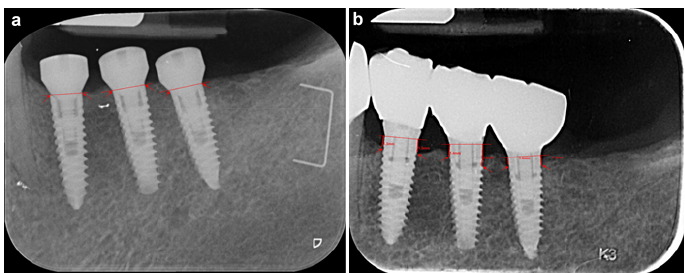
Figure 1. A periapical radiograph at the implant site, at implant placement date T0 and at the last follow-up visit T f . ( a ) Intraoral periapical radiograph of three implants replacing left mandibular premolar and first and second molars at T0. The drown lines and arrows do not show any mesial and distal distance between implant shoulder and the bone crest (no bone resorption is observed). ( b ) Intraoral periapical radiograph of the same implants at T f , 8 years later. The drown lines depict mesial and distal distance between implant shoulder and the bone crest (1.3 mm; 1.5 mm, 1.4 mm; 2.6 mm, 1.0 mm;1.3 mm, respectively mesial and distal from the second premolar to the second molar).